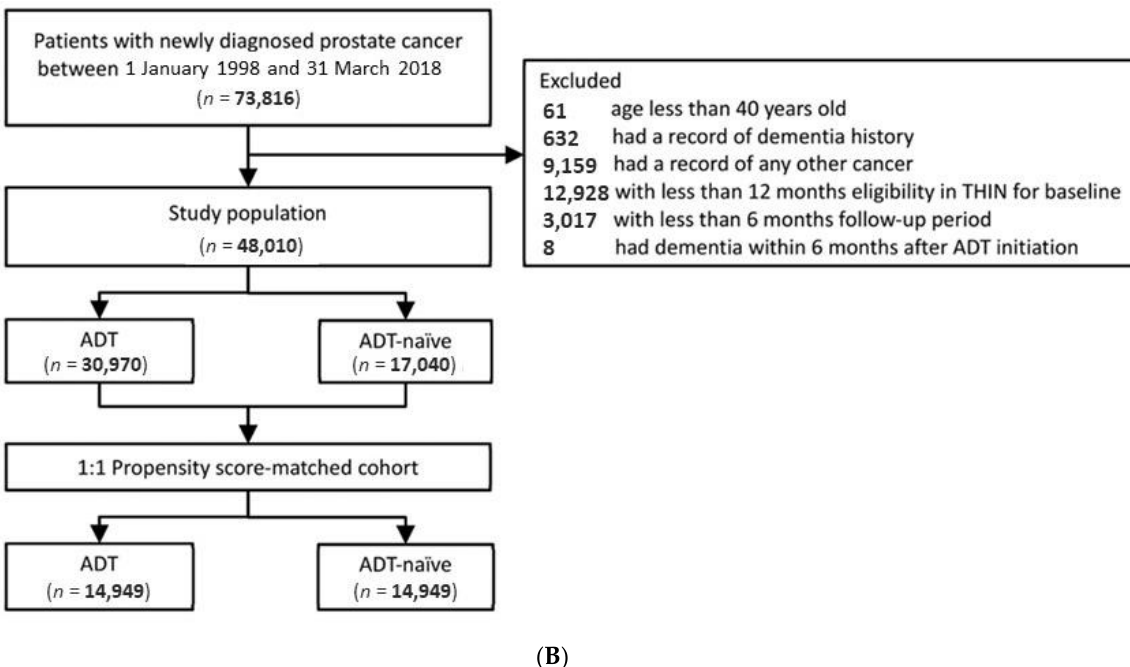
Figure 1. Study cohort selection flowchart: ( A ) the NHID of Taiwan; ( B ) the THIN database of the UK. ADT: androgen deprivation therapy; NHID: National Health Insurance Database; THIN: The Health Improvement Network; UK: United Kingdom.